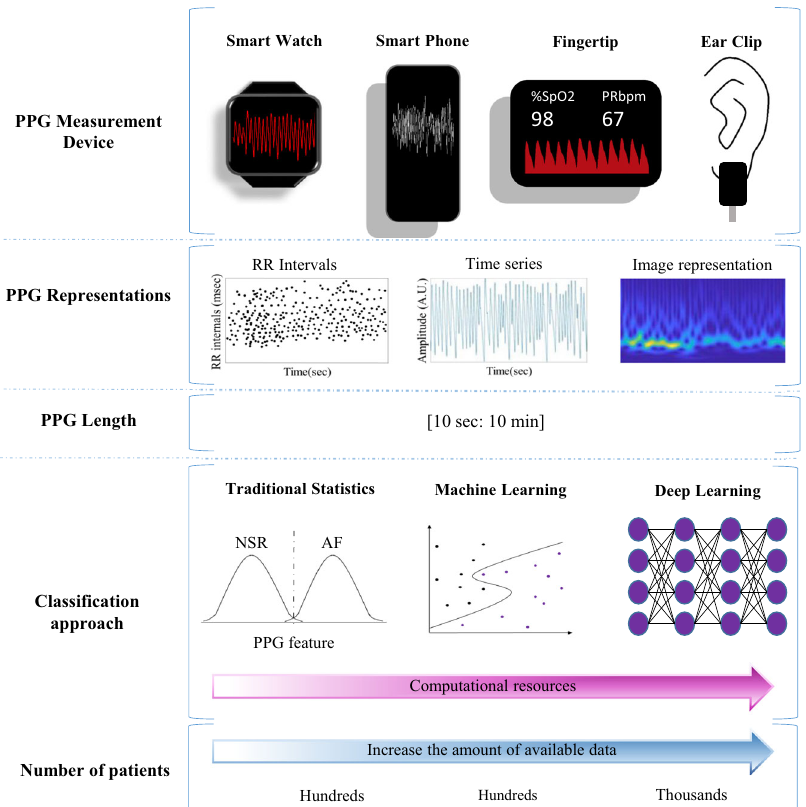
Fig. 2 Overview of the main features extracted from PPG signals used in the studies reviewed (see Tables 1 – 3). SpO2 oxygen saturation, PRbpm pulse rate (beats per